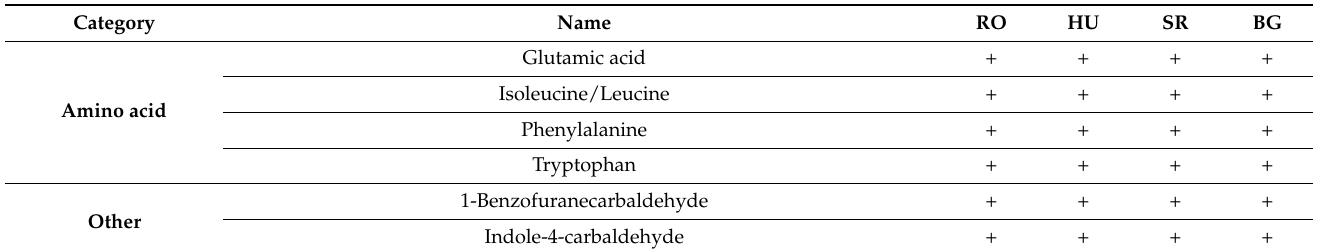
Table 1. Phytochemicals identified by UHPLC-ESI-MS analyses in the RO, HU, SR and BG popula- tions.